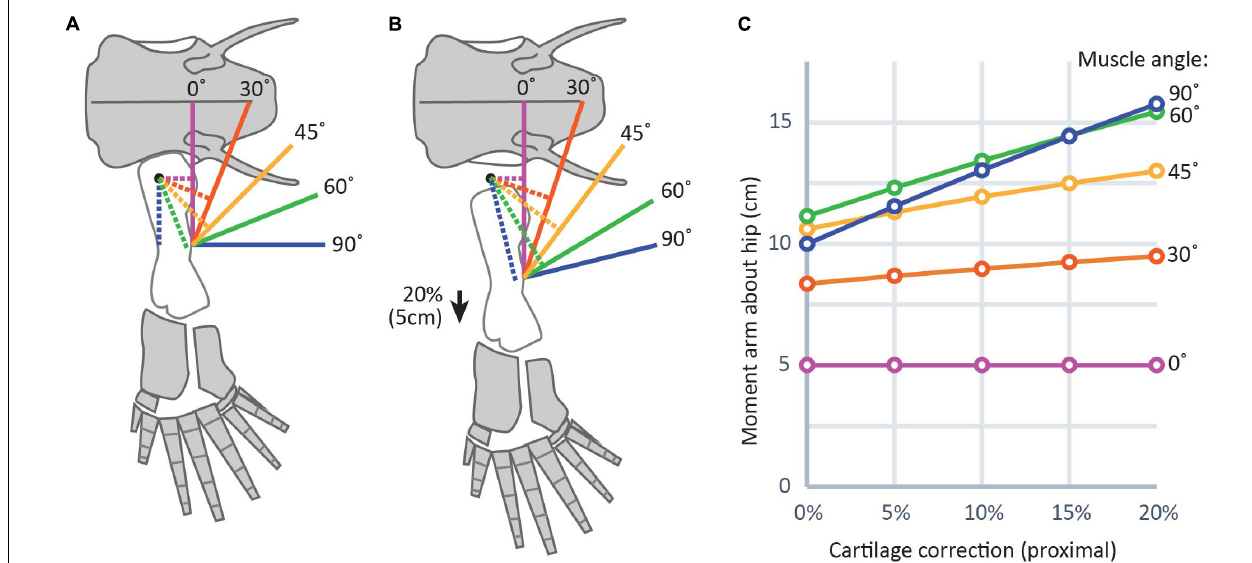
FIGURE 6 | Graphical representation of the effect of cartilage corrections on two-dimensional moment arms about the hip joint. (A) and (B) show a diagram of the hindlimb in Acanthostega (bone outlines modified from Coates, 1996) (25 cm femur length used for simplicity) without cartilage correction (A) and with cartilage correction of 20% femur length (B) , roughly equivalent to the thickness of proximal cartilage caps in the femur of Necturus . Solid lines indicate muscles and dotted lines indicate moment arms. (C) Shows a plot of change in moment arms of the modeled muscles with different cartilage correction factors. Muscles with lines of action nearly parallel to the long axis of the femur (purple, red) show smaller effect sizes; i.e., flatter slopes in part (C) , while those with lines of action more nearly perpendicular to the femur (green, blue) show greater effect sizes; i.e., steeper slopes in part (C) .